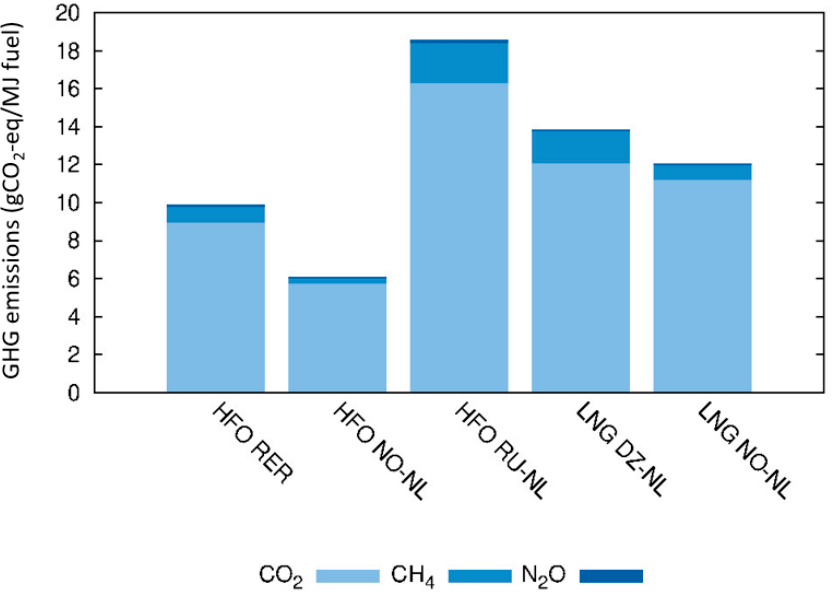
Figure 6. Contribution of the different GHGs to the cradle-to-tank GHG footprint.